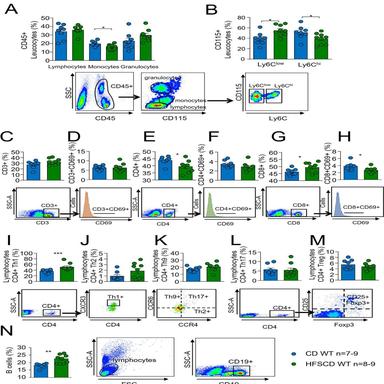
Analysis of circulating leukocyte subsets in mice demonstrated an inflammatory profile in HFSCD-fed WT mice. (A) Percentage of circulating lymphocytes, monocytes and granulocytes identified in the CD45+ blood cell population by morphology and with the help of CD115+ monocyte marker. (B) CD45+CD115+Ly6Clow and CD45+CD115+Ly6Chi monocyte subset percentages identified in the CD45+CD115+ cells in both groups of mice. Circulating percentages of (C) CD3+ T cells and their subsets (E) CD4+ and (G) CD8+ displayed a